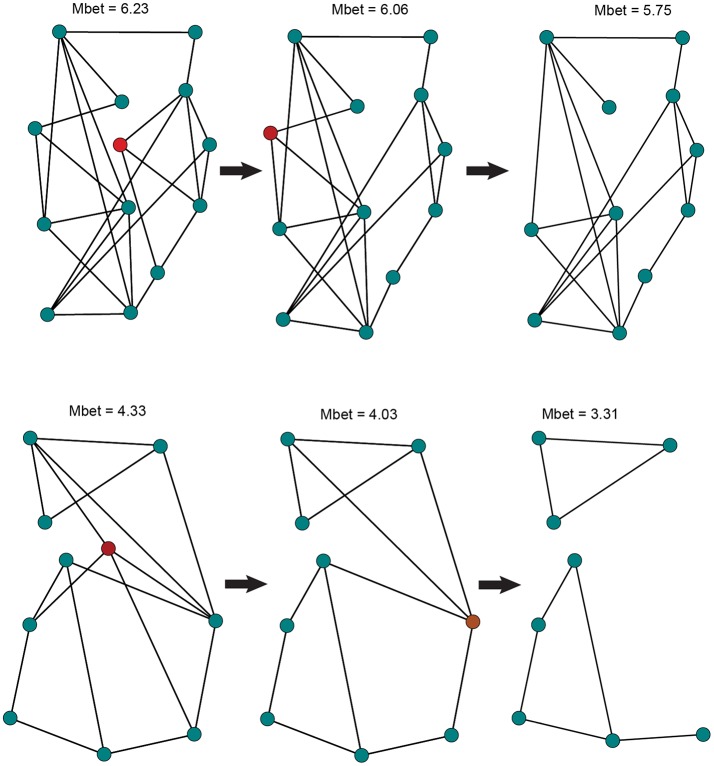
Illustration of the node removal procedure used to simulate population extinction events in NIDGS (top) and SIDGS (bottom). In each step, a randomly selected node (in red), representing a sampling location, is removed from the network along with the edges connecting it to additional nodes. Network mean betweenness values are given on top. Following the removal of 2 nodes, the SIDGS network fails to create a single component, becoming fragmented.